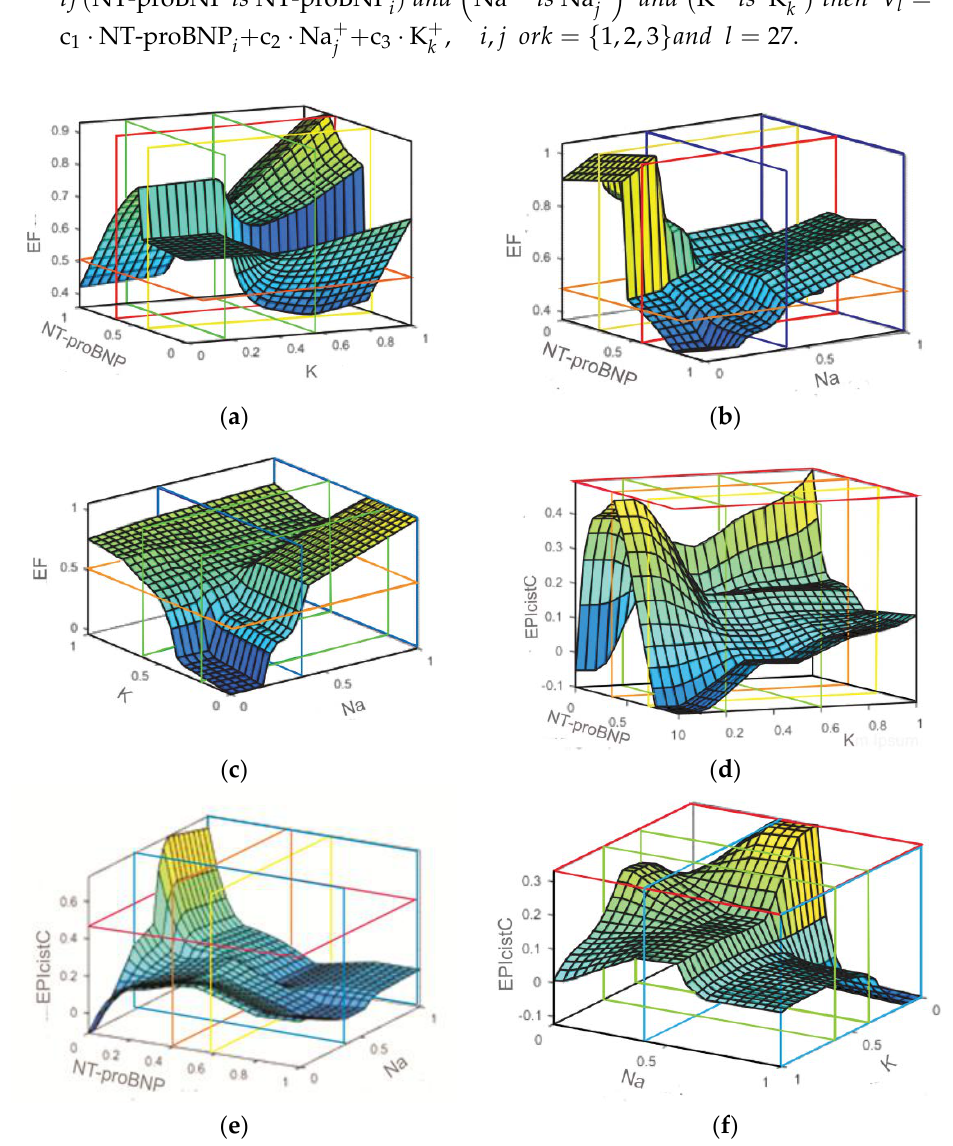
Figure 2. Estimation of ANFIS network of interdependence areas of parameter values: EF values as a functional dependence ( a ) NT-pro BNP and K+, ( b ) BNP and Na+, ( c ) Na+ and K+, and CKD- EPIcystatin C as a functional dependence ( d ) NT-proBNP and K+, ( e ) NT-proBNP and Na+ i ( f ) Na+ and